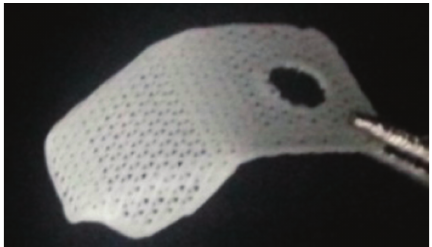
Figure 4: A PCL/PLGA/ 𝛽 -TCP membrane produced using 3D printing technology. Pores were triangularly structured and com- pletely interconnected (originally adapted from